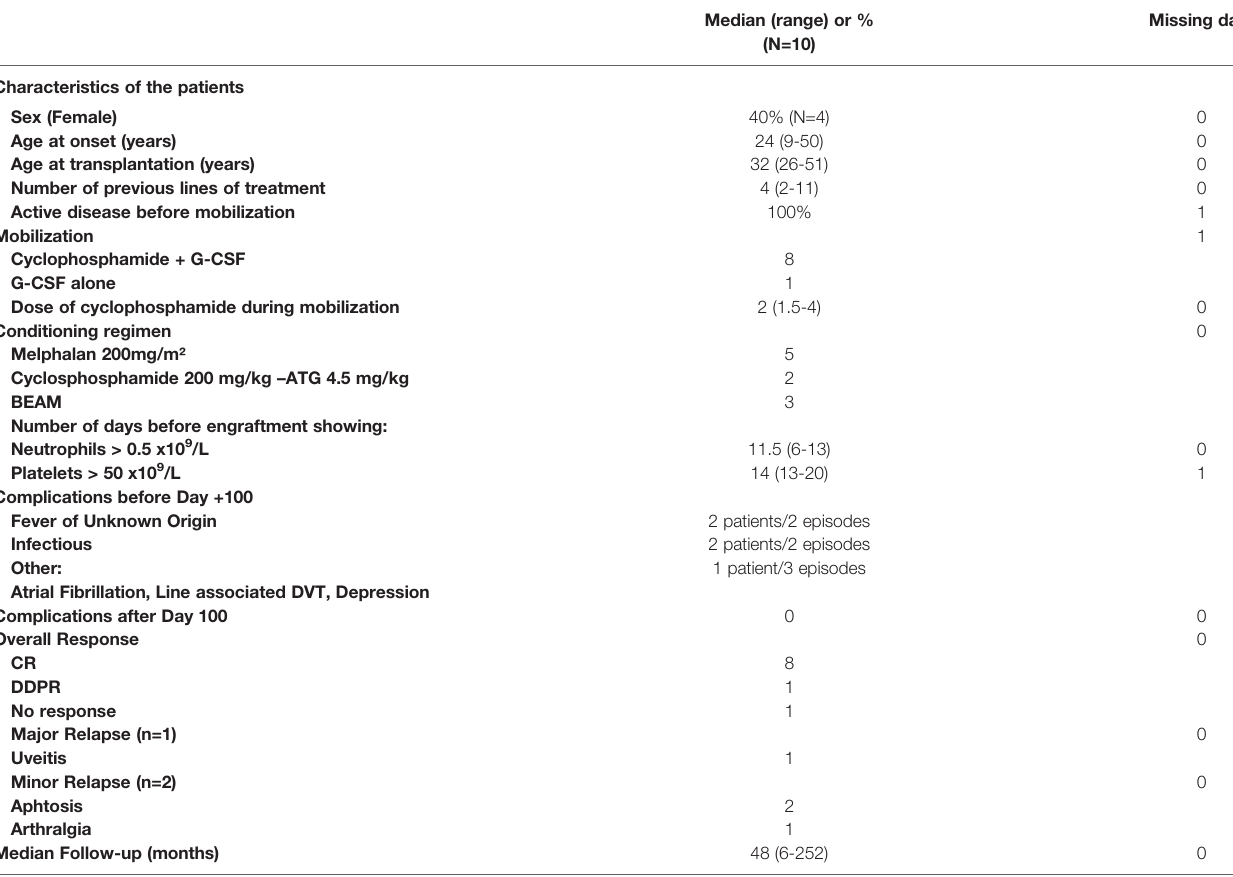
Median (range) or % Missing data (N=10)